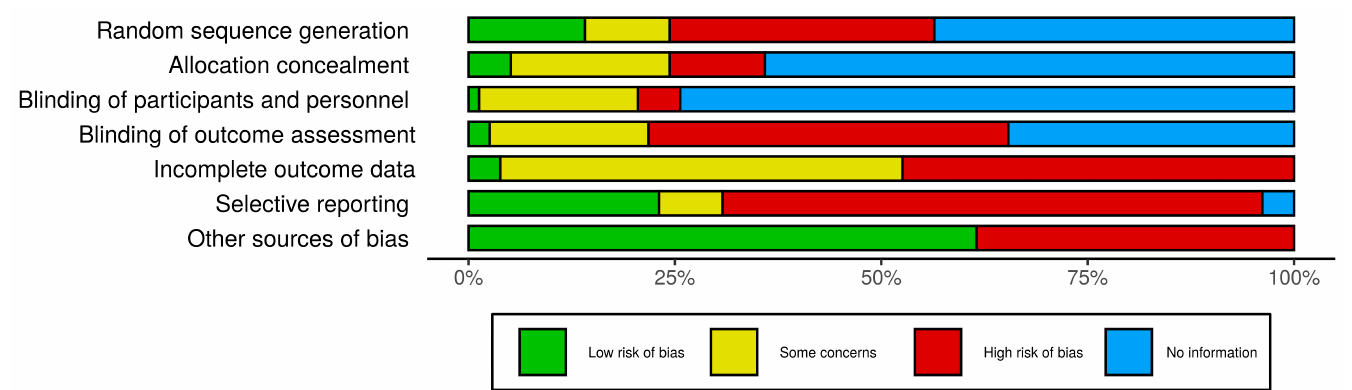
Figure 2. Risk of bias assessment. Evaluation of the methodological quality and assessment of the risk of bias using the